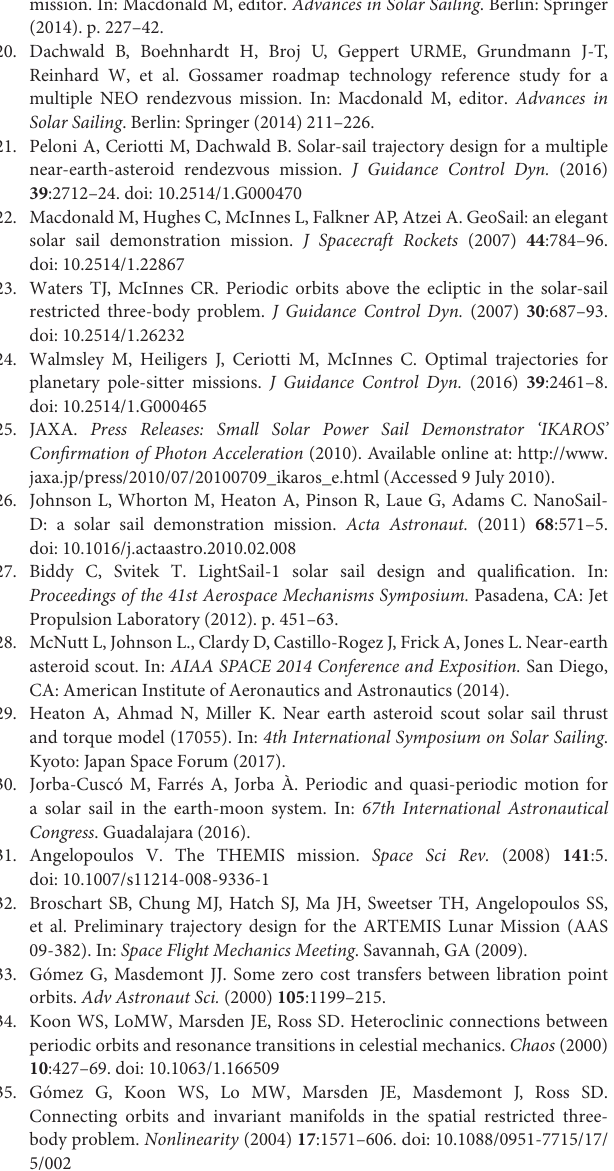
figure of merit to assess the quality of the connections, and using grid searches on the departure, arrival and linkage times as well as on constant, non-zero solar-sail pitch angles in the unstable and stable manifold trajectories. While these methods allowed to find homo- and heteroclinic connections with errors on the position and velocity at linkage of < 1,525 km and < 25 m/s, true connections were only found when exploring the design space in between the discrete mesh of the grid search. For this a genetic algorithm approach has been successfully applied, reducing the errors down to < 10 km and < 1 m/s. With that, this paper has proven the feasibility of homo- and heteroclinic connections